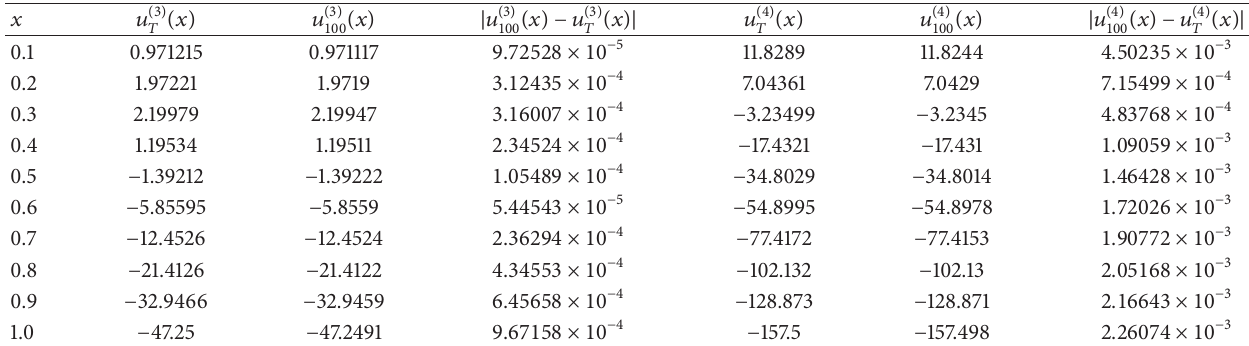
Table 4: The numerical results of Example